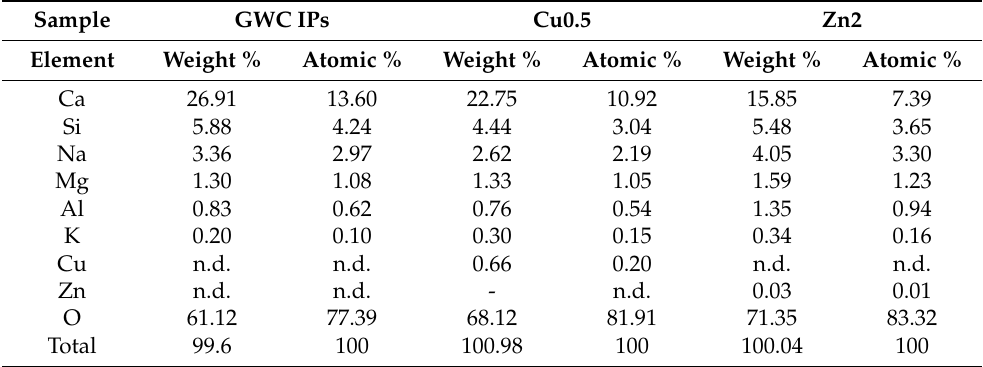
Table 2. Elemental composition for GWC IPs embedded with 0.5% CuO and 2% ZnO NPs.